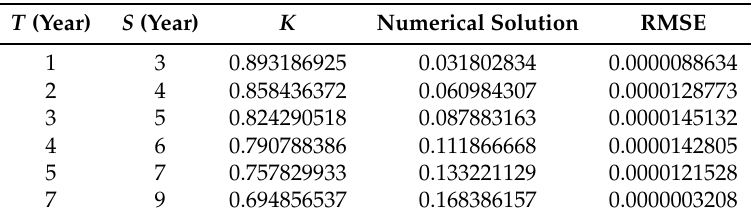
Table 3. Computational results of the one-asset numerical